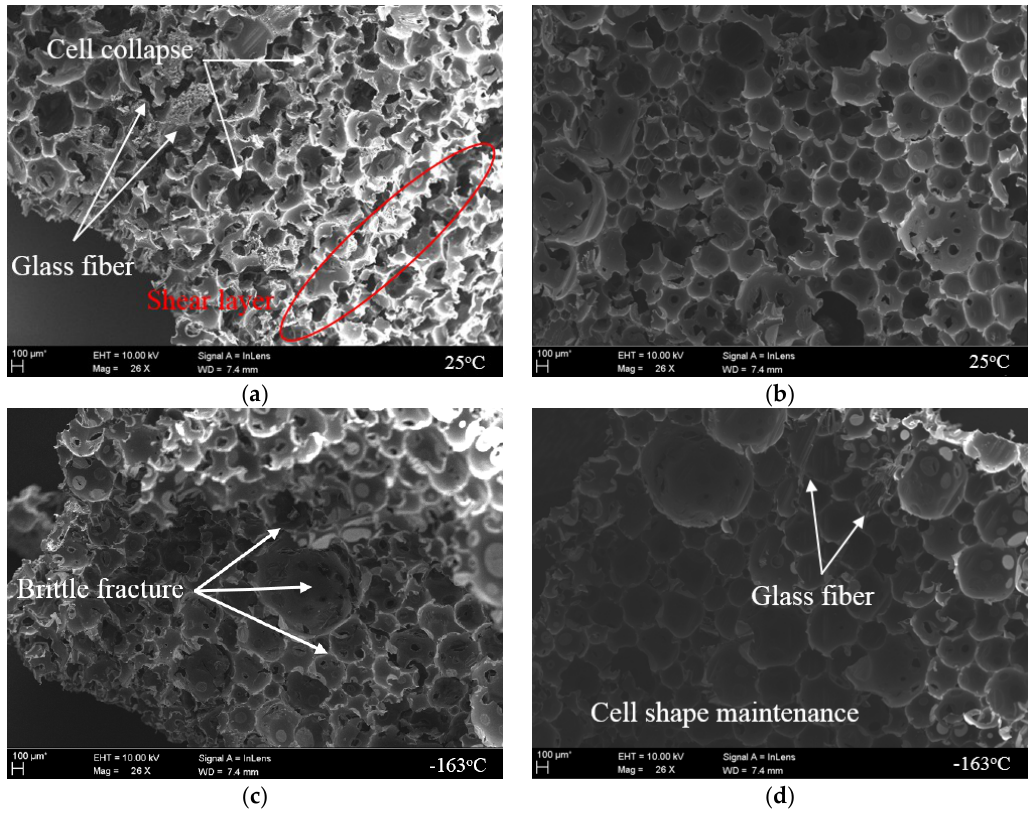
Figure 13. Microstructure inside the RPUF after the compressive tests according to the restraint condition. ( a ) non-restraint at 25 °C; ( b ) restraint at 25 °C; ( c ) non-restraint at −163 °C; ( d ) restraint at −163 °C